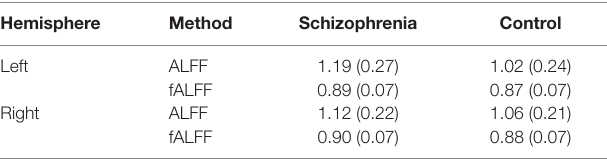
TaBle 2 | Means and sDs of alFF and falFF for the hippocampus in each group.